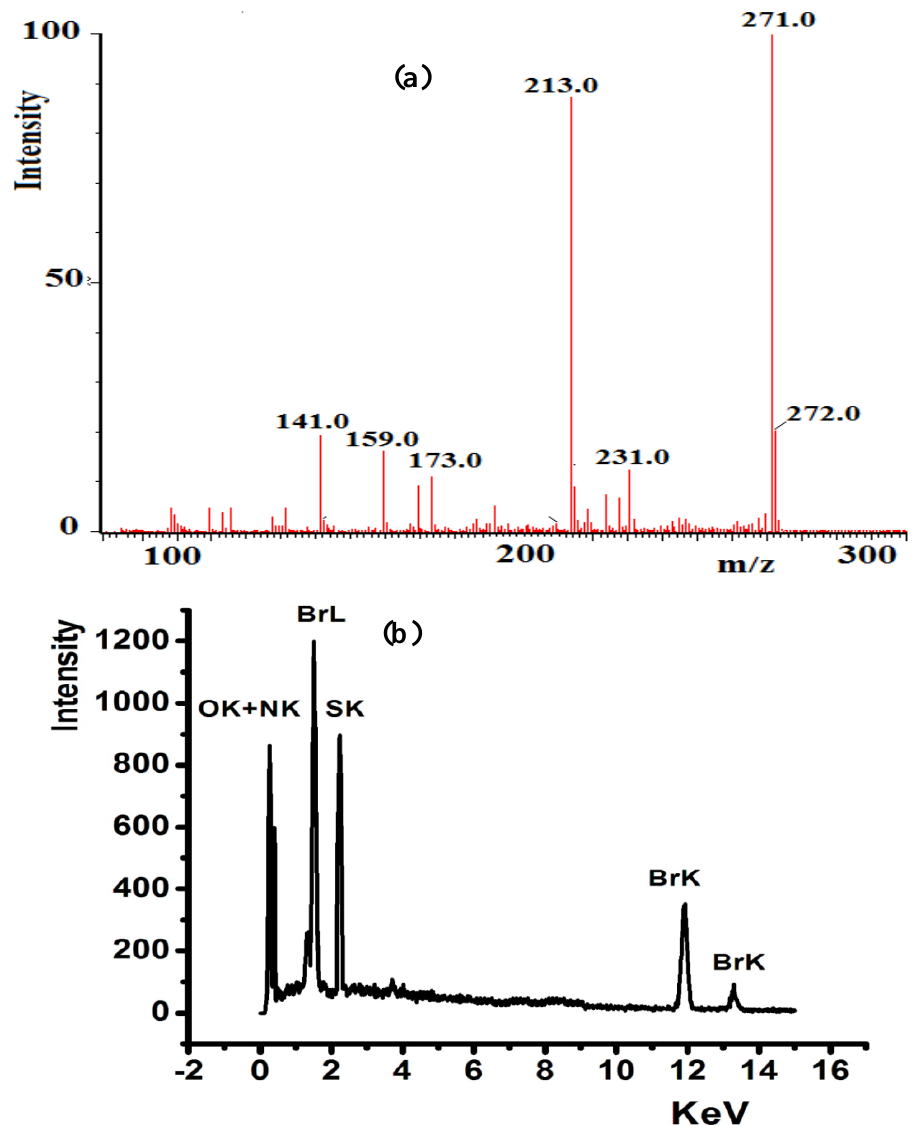
Figure 2. ( a ) ESI-MS of L1 and ( b ) EDS spectrum of L3.